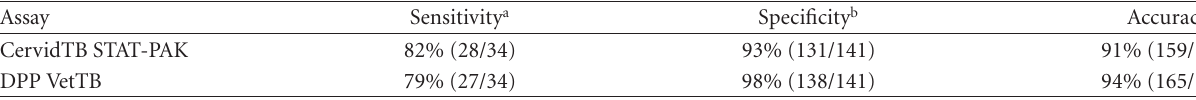
Table 2: Diagnostic performance of serological tests in elk.